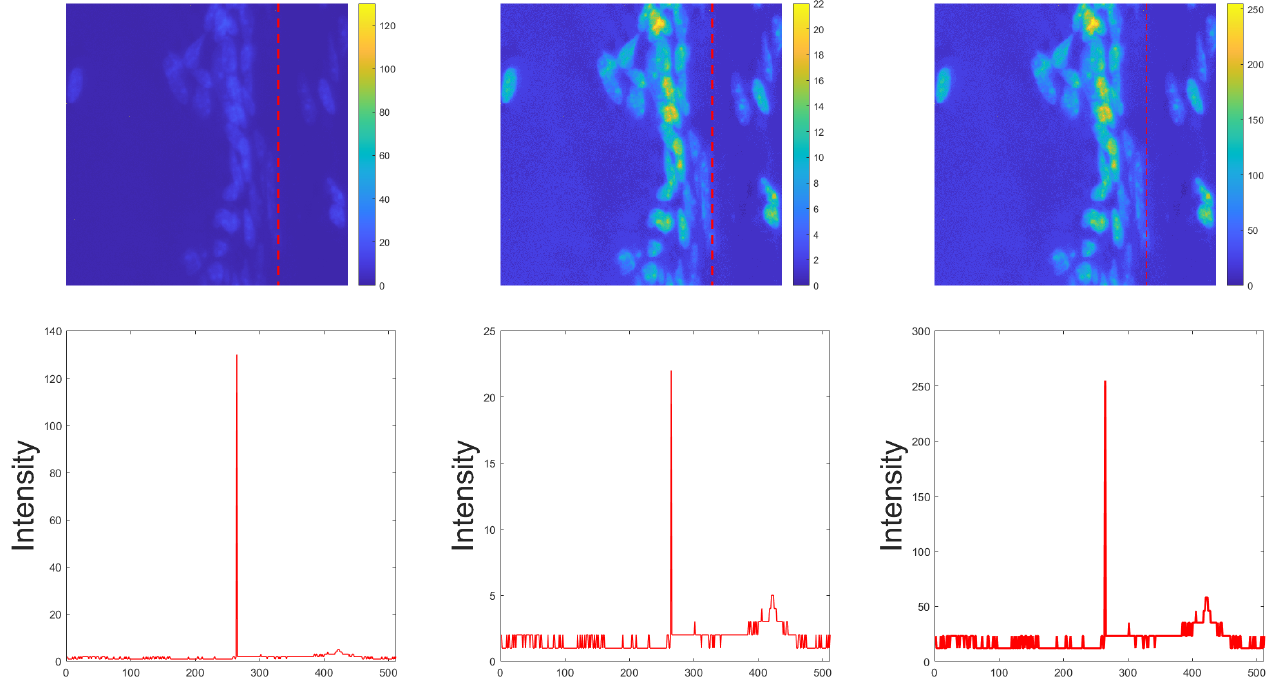
Figure 3. Example of raw, outlier-removed and normalised 8 bit images of a bone sample at 40 × magnification from left to right in the first row, respectively. We also plot a profile intensity line (depicted with dashed red lines in the images) in the second row. The raw 8 bit image was selected from the BitDepth dataset and corresponds to the 16 bit image presented in Figure